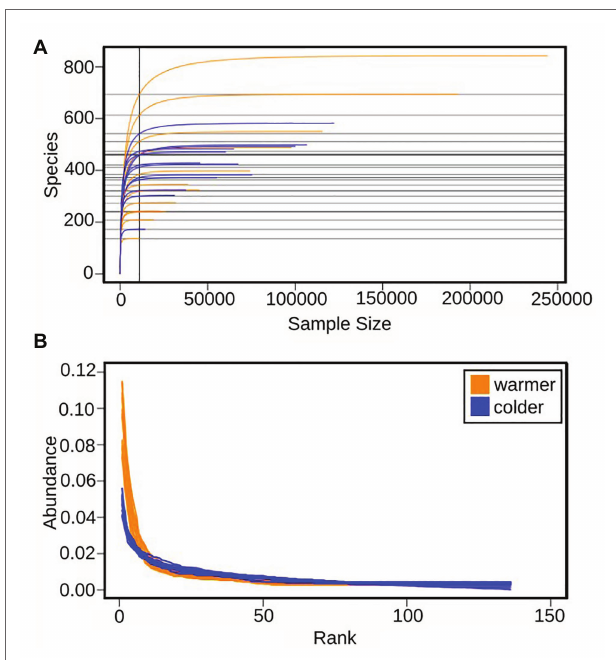
FIGURE 4 | Diversity measures of 16S ASVs, excluding ASVs annotated as chloroplasts. (A) Rarefaction curves, plotting sample size vs. number of ASVs. (B) Normalized rank abundance curves, plotting ASVs, ranked by abundance vs. abundance (counts). Orange – warmer period, blue – colder